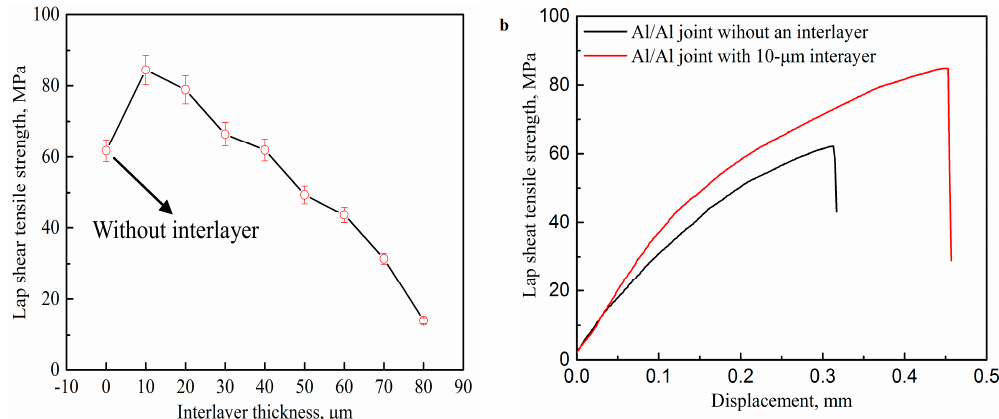
Figure 10. ( a ) Relationship between the lap shear tensile strength and the interlayer thickness for the ultrasonic spot-welded (USWed) Al/Al joints; ( b ) the load-displacement curves for the joints without an interlayer and with a 10- μ m interlayer.